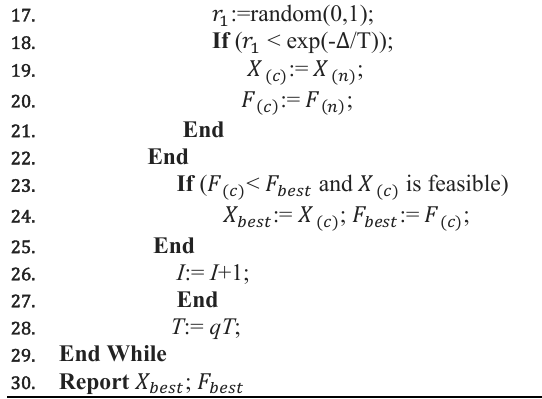
Fig. 2. Pseudocode of the SA algorithm